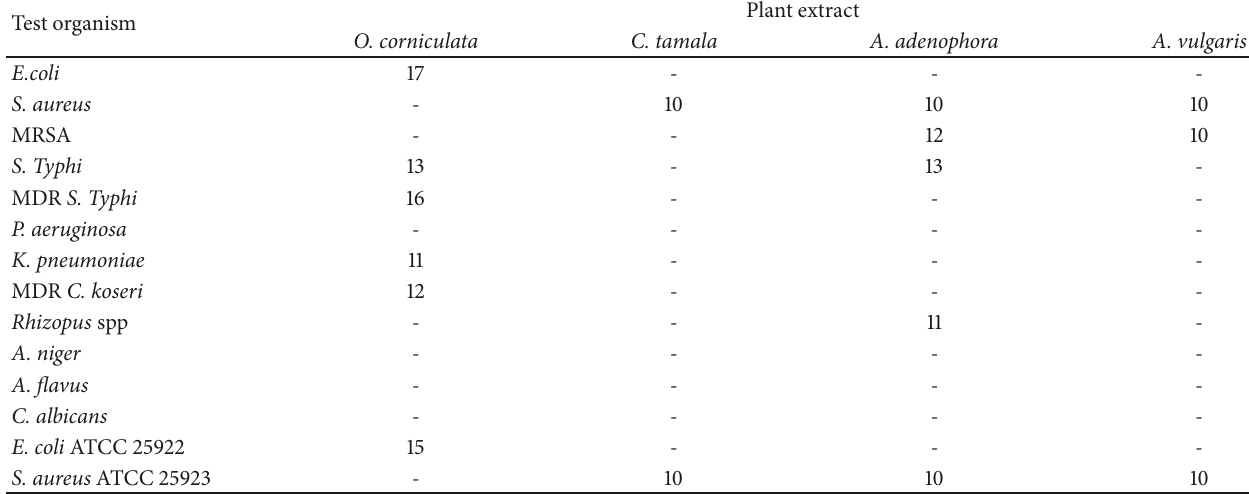
Table 3: Diameter of zones of inhibition (mm) of plant extracts against microorganisms at 50mg/ml concentration. Test organism